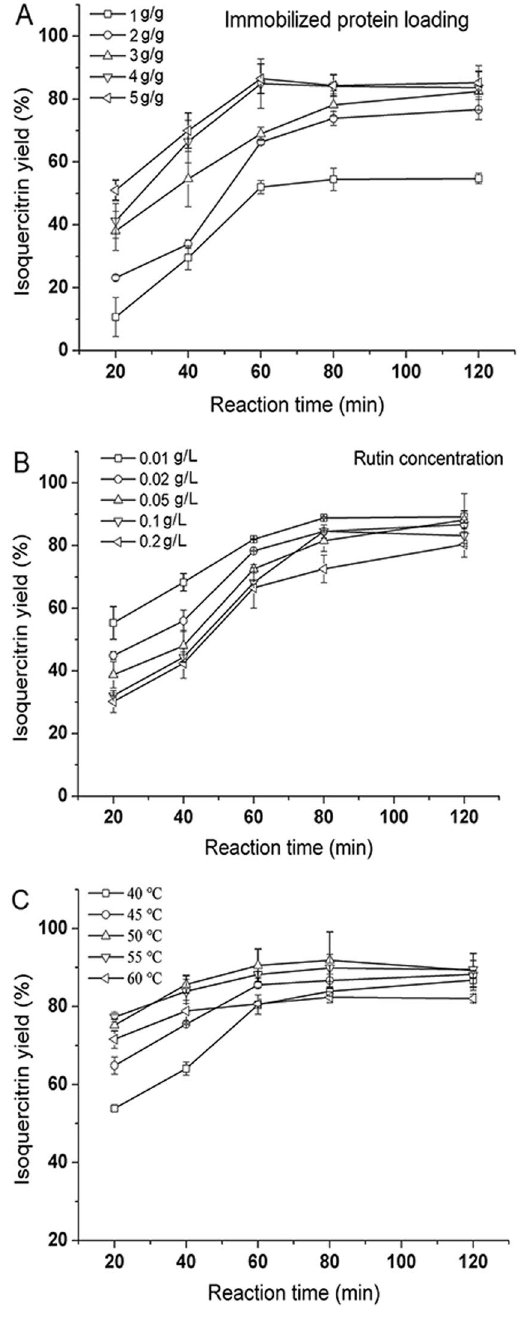
Figure 6. Effect of immobilized protein loading ( A ), rutin concentration ( B ) and reaction temperature ( C ) on isoquercitrin yield in a batch reactor. Reaction conditions: the mixture was in a 4 mL reaction system and obtained at 20, 40, 60, 80 and 120 min. ( A ) rutin concentration was 0.1 g/L and the mixture was shaken at 50 °C; ( B ) the nanoparticle mass was 20 mg (protein loading of 4 g g − 1 of support) and the mixture was shaken at 50 °C; ( C ) the rutin concentration was 0.1 g/L and the nanoparticle mass was 20 mg (protein loading of 4 g/g of